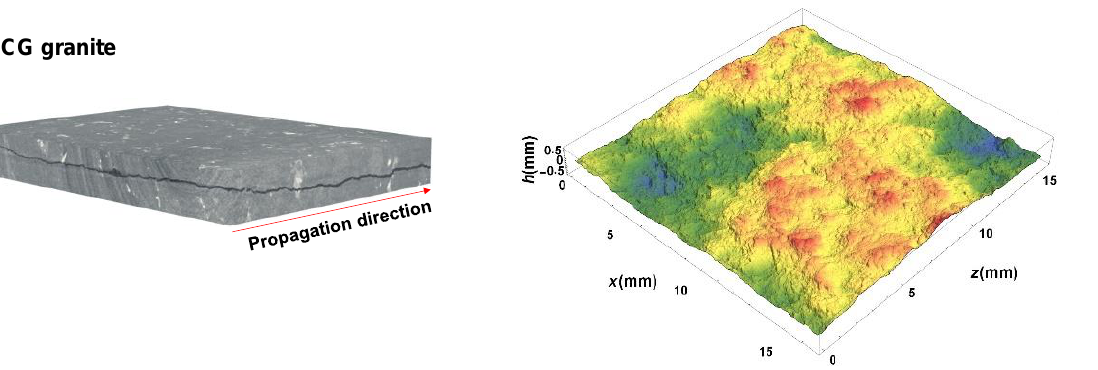
Figure 1. The 3D X-ray computed tomography images of the fractured area and topographic images of fractured surfaces of sandstone ( a ), marble ( b ) fine-grained granite ( c ), and coarse grained granite ( d ). The x-axis and z-axis correspond to the crack propagation direction and the crack front direction, respectively. The real length of reconstructed CT images is around 18 mm in the propagation direction.